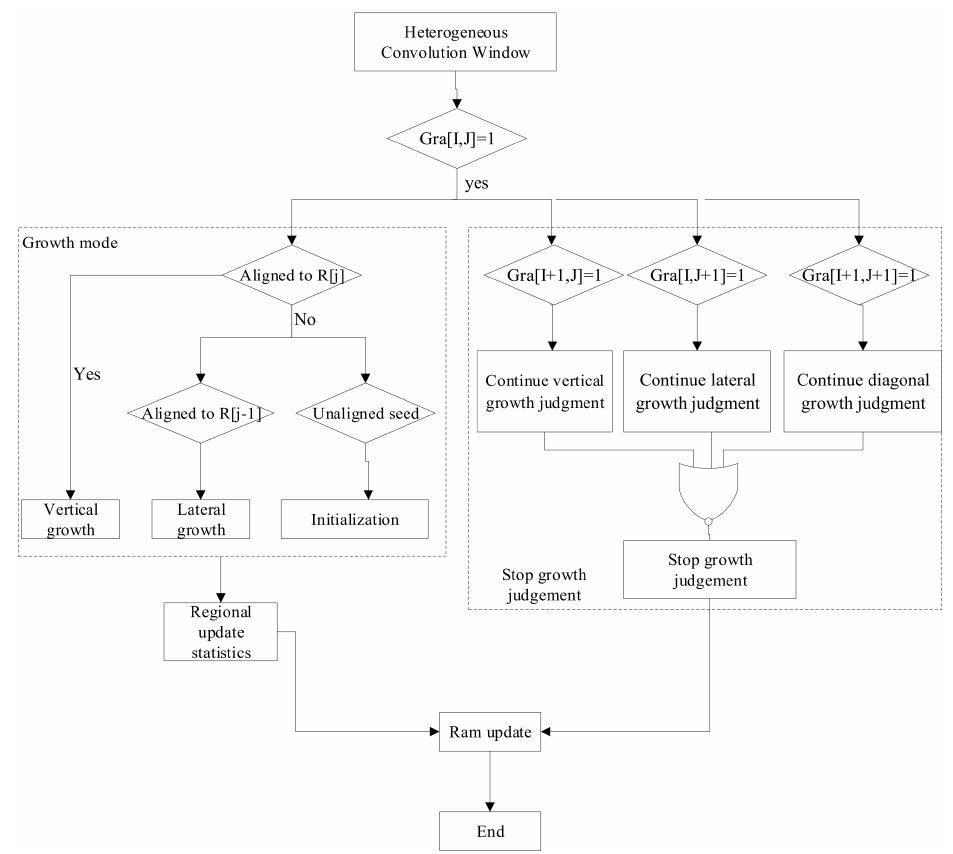
Figure 13. Area update